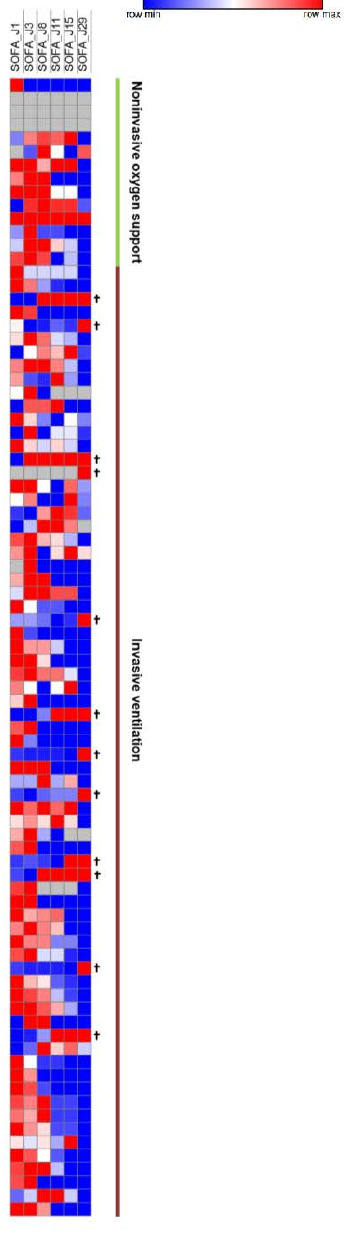
Figure 4. SOFA Scores Heatmap. SOFA scores at day 1, 3, 8, 11, 15, and 29. Increasingly blue colors mean improved SOFA scores compared to J1; increasingly red colors mean worsened SOFA scores compared to J1. Each row corresponds to a patient.